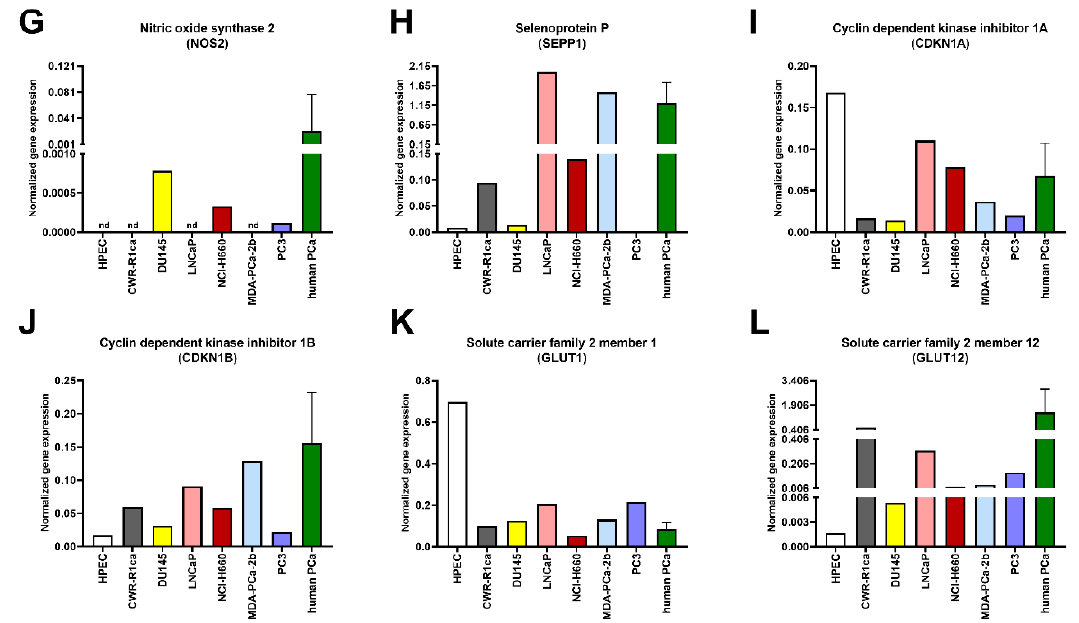
Figure 3. Transcript levels of potential oncogenic mediators in prostate-cancer cell lines and in human prostate-cancer tissue. Transcript levels of indicated genes measured using real-time PCR. ( A ) MKI67 , ( B ) CCND1 , ( C ) TP53 , ( D ) HIF1A , ( E ) RELA , ( F ) BIRC5 , ( G ) NOS2 , ( H ) SEPP1 , ( I ) CDKN1A , ( J ) CDKN1B , ( K ) GLUT1 , ( L ) GLUT12 . PCa: prostate cancer, HPEC: parental primary prostate cells, CWR-R1ca: xenograft PCa cells, DU145: brain metastasis PCa cells, LNCaP: lymph-node metastasis PCa cells,